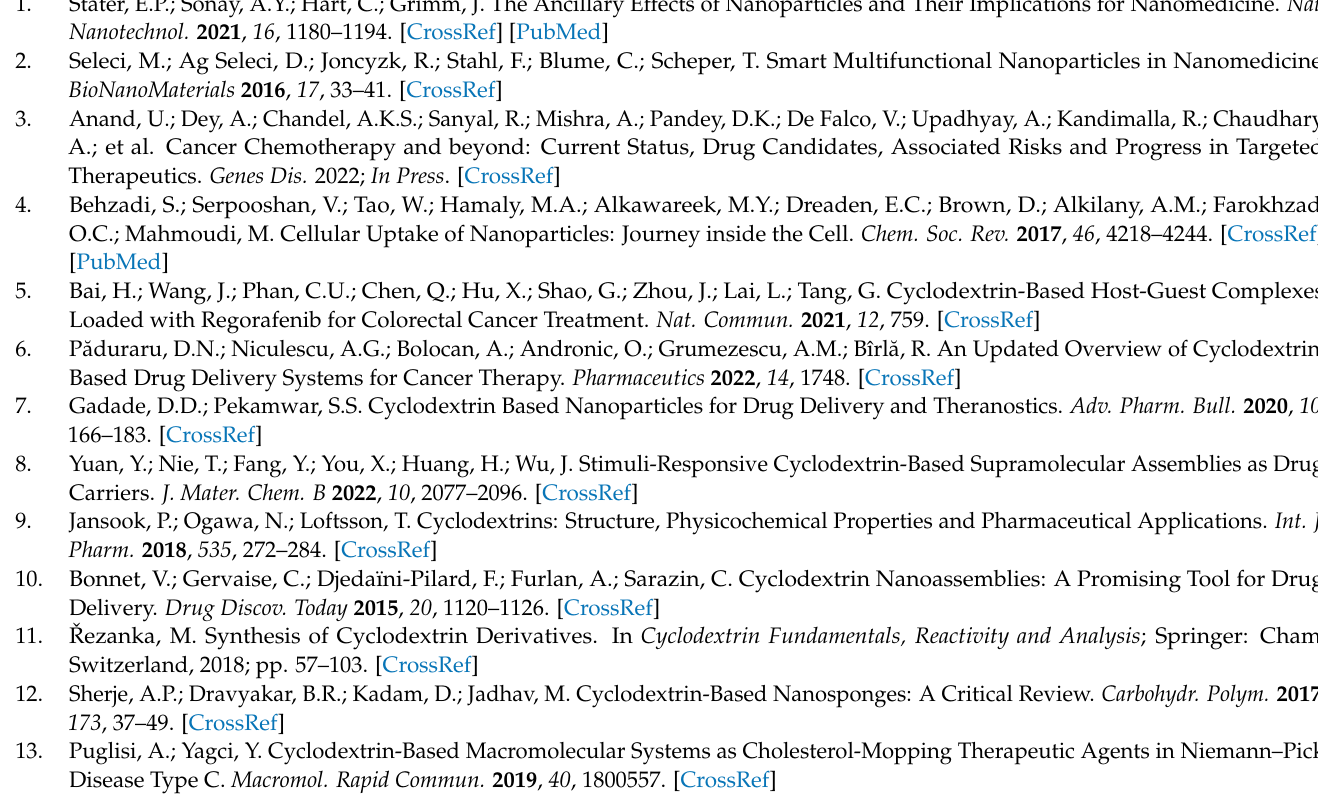
curves of SK-N-SH (top) and SK-N-SH-PMA (bottom) cells treated with DOXO, DOXO/HAL β CyD, or DOXO/HAH β